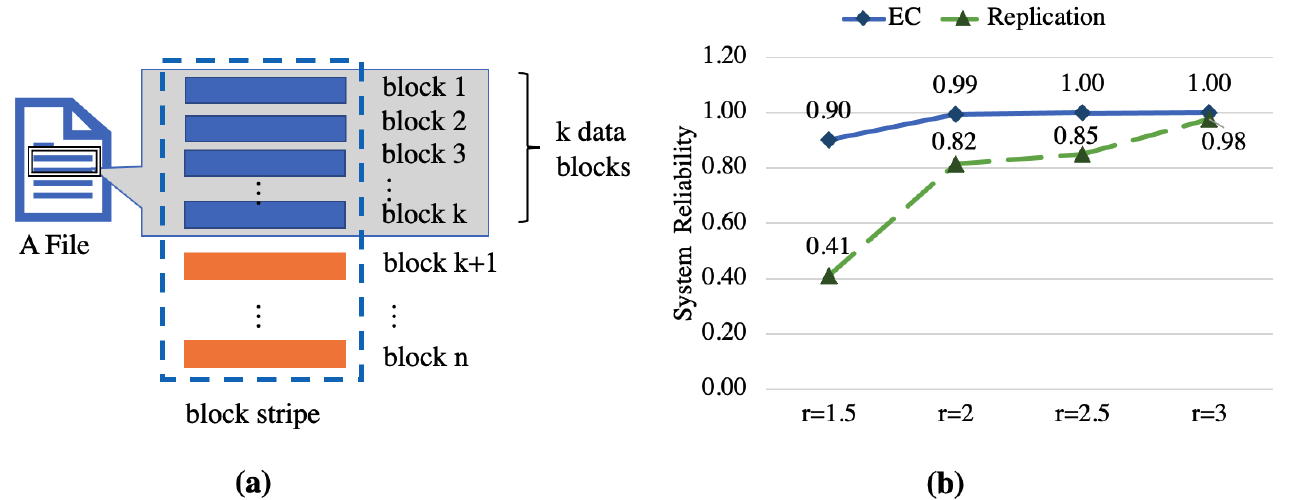
Figure 1. ( a ) Terminology of Erasure Code (EC). In the blue dashed box is a stripe consisting of k blue data blocks and n − k orange parity blocks. ( b ) System reliability of EC and replication while reliability p = 0.8. The reliability of the replication strategy is lower than EC while r is smaller, and EC can guarantee more than 90% reliability in any